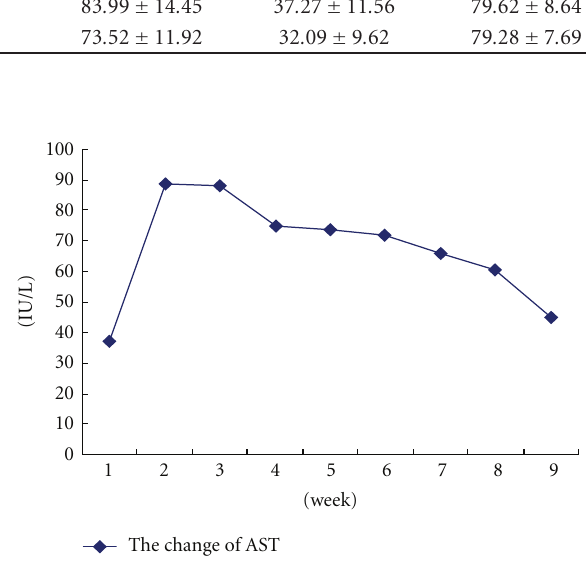
Figure 2: The change of AST during